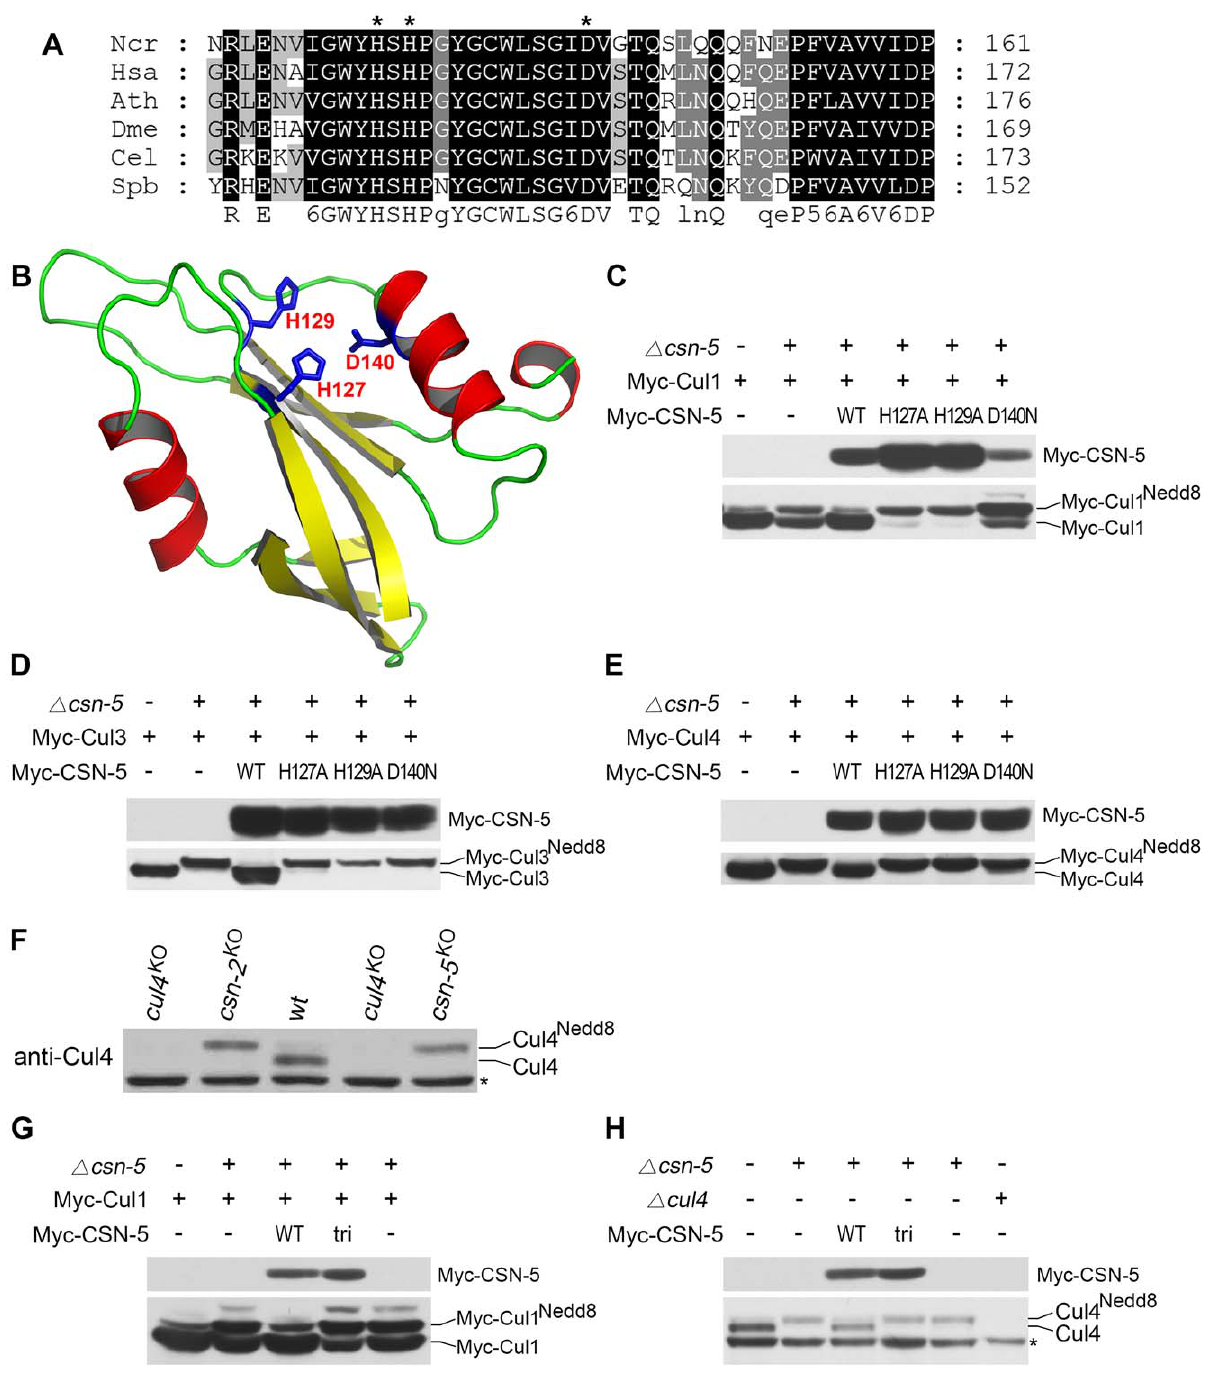
Figure 1. Mutations within the JAMM motif of CSN-5 abolish CSN–mediated deneddylation activity for Cul1, Cul3, and Cul4. (A) Amino acid alignment of conserved JAMM motifs of CSN-5 homologs from Neurospora crassa (Ncr), Homo sapiens (Hsa), Arabidopsis thaliana (Ath), Drosophila melanogaster (Dme), Caenorhabditis elegans (Cel), and Schizosaccharomyces pombe (Spb). (B) Predicted structure of the N. crassa CSN-5 JAMM domain. The structure was generated by the SWISS-MODEL using the structure of the pre-mRNA splicing factor Prp8 as template (PDB accession number 2P8R), and the functional sites (His127, His129, and Asp140) were mapped according to the structure alignment with the AfJAMM structure (PDB accession number 1R5X). (C–E) Western blot analyses with c-Myc antibody of expression profiles of Myc-Cul1 (C), Myc-Cul3 (D), and Myc-Cul4 (E) in the wild-type strain, csn-5 KO , and CSN-5 complementation strains. (F) Western blot analysis showing the expression of Cul4 in the wild- type, cul4 KO , and csn-5 KO strains. (G) Western blot analyses with c-Myc antibody of expression profiles of Myc-Cul1 in the wild-type strain, csn-5 KO , and csn-5 KO , pcsn-5-Myc-CSN-5 or csn-5 KO , pcsn-5-Myc-CSN-5tri complementation strains. (H) Western blot analyses showing the expression of endogenous Cul4 in the wild-type strain, csn-5 KO , csn-5 KO , pcsn-5-Myc-CSN-5 or csn-5 KO , pcsn-5-Myc-CSN-5tri complementation strains. The asterisk indicates a nonspecific cross-reacted protein band recognized by our Cul4 antiserum (in F and H).